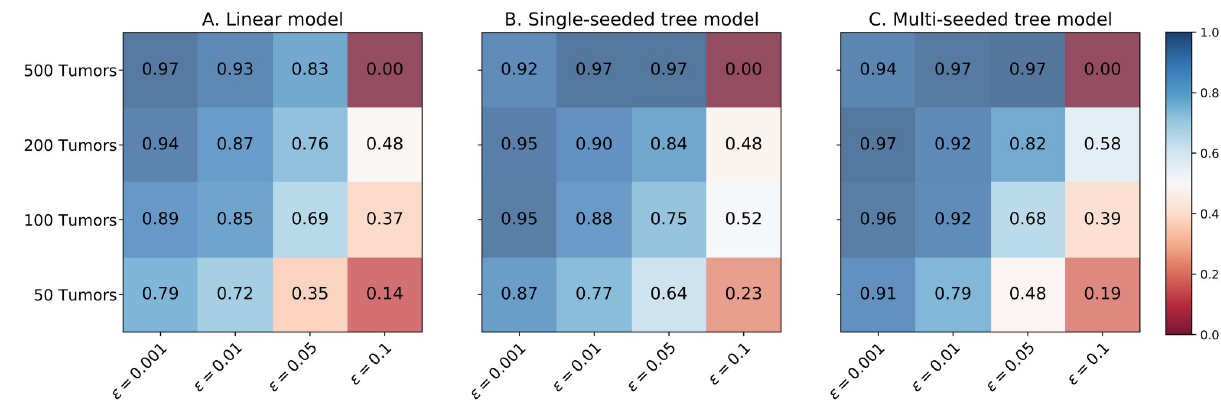
Fig 5. The averaged F overall scores achieved in the synthetic data experiments in the case of A . linear model B . single-seeded tree model C . multi-seeded tree model.